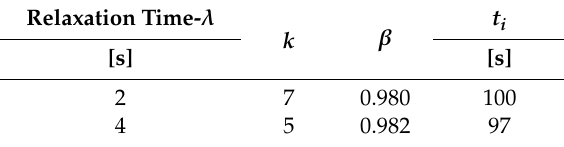
Table 5. Parameters of the relaxation modulus by EPL expression.